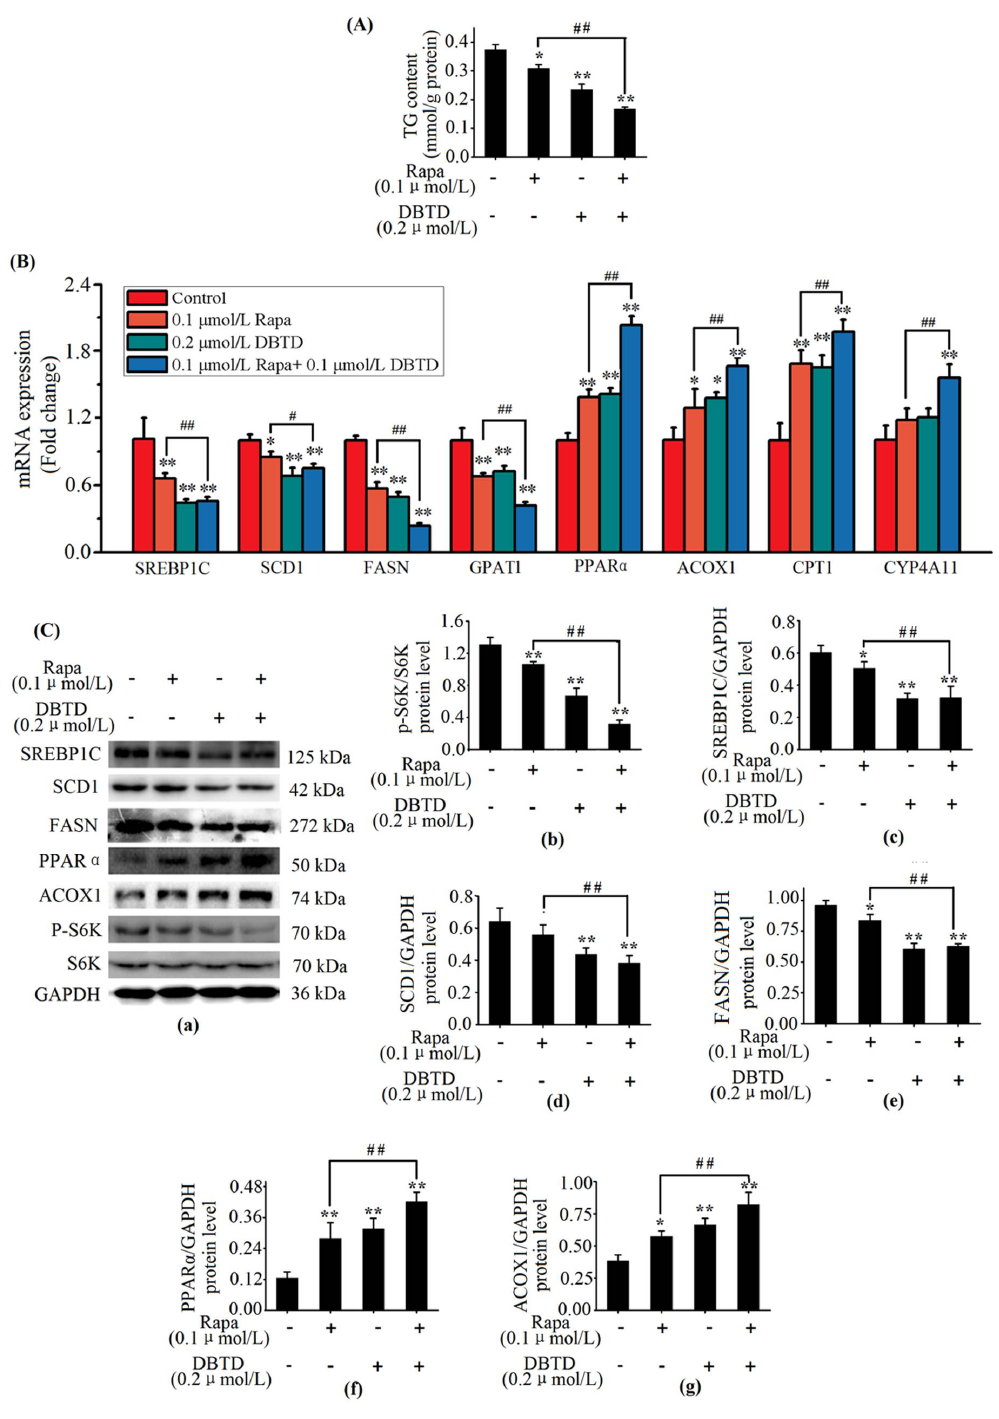
Figure 6. Effects of DBTD on the mTOR pathway and triglyceride (TG) metabolism. Cells were treated with 0.1 μmol/L rapamycin (Rapa) for 6 h, 0.2 μmol/L DBTD for 24 h, and pretreated with 0.1 μmol/L Rapa for 6 h followed by a 24 h treatment of 0.2 μmol/L DBTD, respectively. The control group (Con) was incubated with culture media only. ( A ) measurement of intracellular TG content. ( B ) Expressions analysis of SREBP1C , SCD1 , FASN , GPAT1 , PPARα , ACOX1, CPT1 , and CYP4A11 by RT-PCR. ( C ) Protein analysis by immunoblot, ( a ) representative bands of relevant proteins. Protein levels of ( b ) p-S6K1 (Thr421), ( c ) SREBP1C, ( d ) SCD1, ( e ) FASN, ( f ) PPAR α , and ( g ) ACOX1. Quantities are expressed as relative intensities against GAPDH except for p-S6K1 (Thr421), which was against S6K1. Data are presented as the mean ± SD of three experiments. * p < 0.05 and ** p < 0.01 versus control. # p < 0.05 and ## p < 0.01 versus Rapa